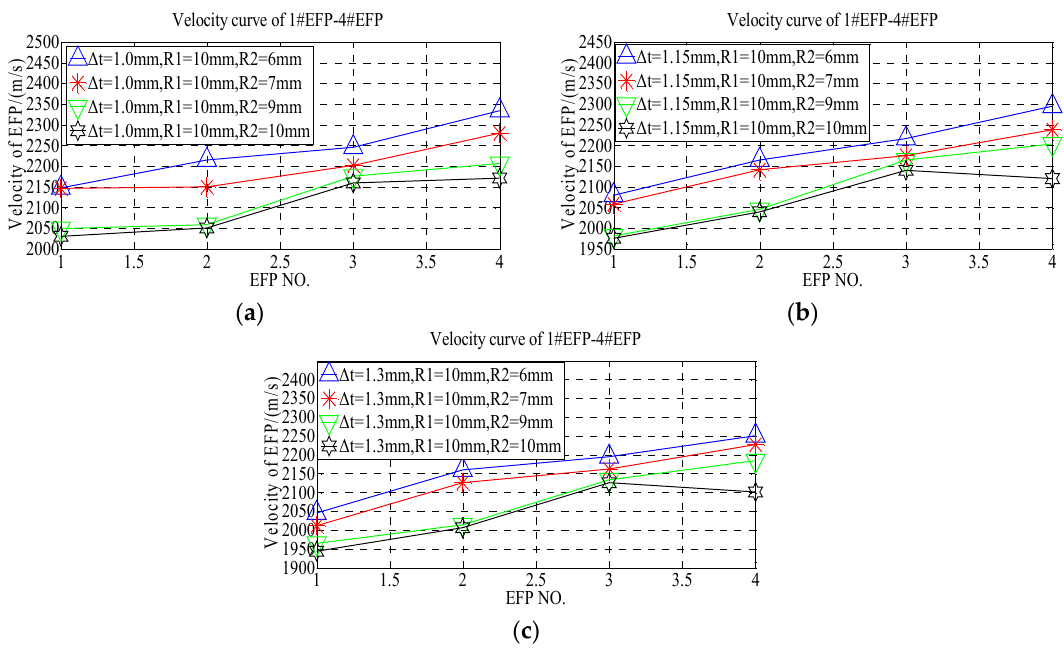
Figure 11. Velocity curve of 1#EFP-4#EFP: ( a ) the center thickness of liner is 1 mm; ( b ) the center thickness of liner is 1.15 mm; ( c ) the center thickness of liner is 1.3 mm.